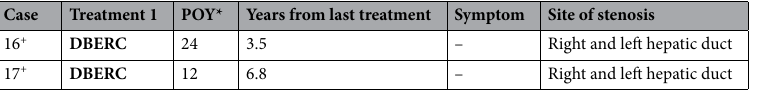
Table 3. Treatment history of two patients with anastomotic and bile duct strictures. DBERC : complete lithotripsy. *POY: post radical operative years. DBERC, double-balloon endoscopic retrograde cholangiography.